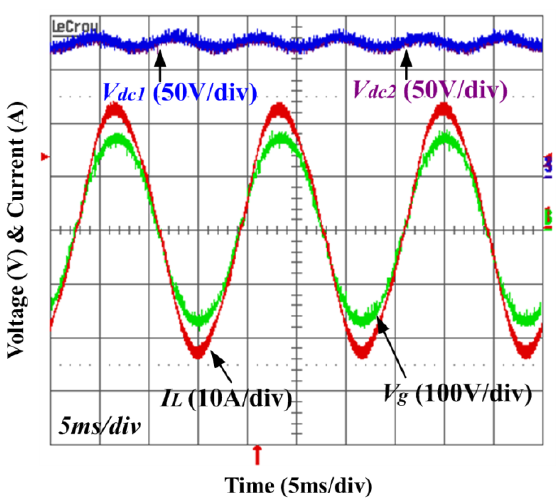
Figure 15. Enlarged experimental results of Figure 13.